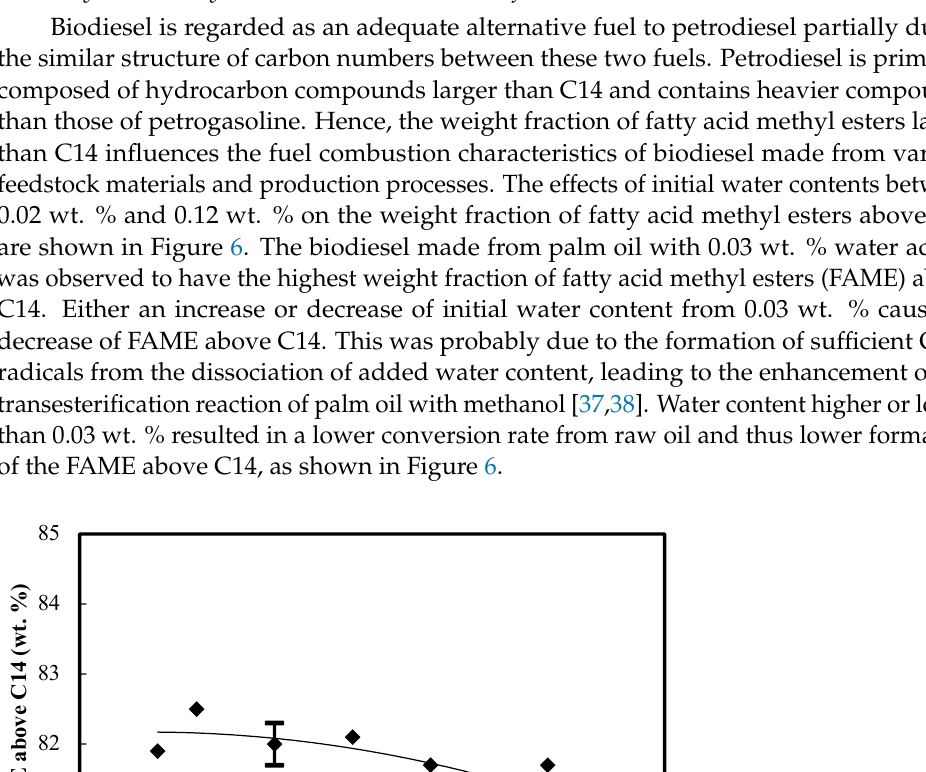
Figure 5. Variations of the cold filter plugging point (CFPP) of the biodiesel product with initial water content in palm oil.